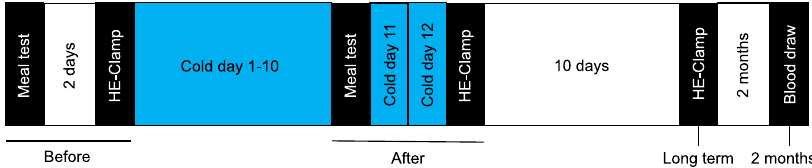
Fig. 1 Study design. A meal test and hyperinsulinemic euglycemic clamp (HE-clamp) were performed before mild cold acclimation, separated by 2 days. After 10 days of cold exposure a second meal test was performed, followed by 2 additional days of cold exposure and followed by a second hyperinsulinemic euglycemic clamp. Ten days after the last intervention day, a third hyperinsulinemic euglycemic clamp was performed (long term). Two months after the last hyperinsulinemic euglycemic clamp another blood sample was collected. The blue boxes represent cold acclimation intervention (16 – 17 °C). The white boxes represent no intervention. The black boxes represent test days.